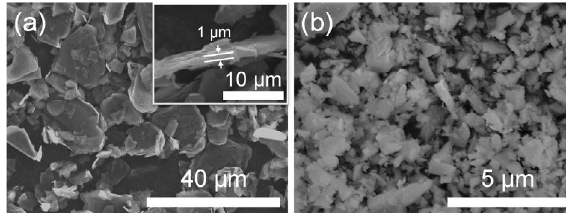
Fig. 1 Morphologies of (a) GF and (b) SiC